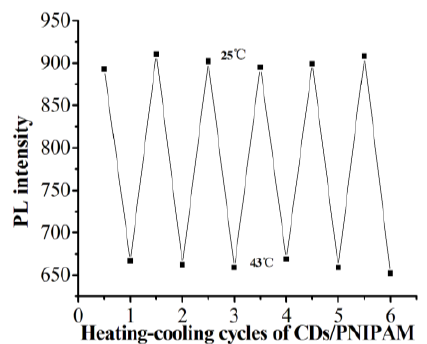
Figure 9. The change in fluorescence intensities of the CDs/PNIPAM aqueous solution during heating/cooling cycles between 25 and 43 °C.